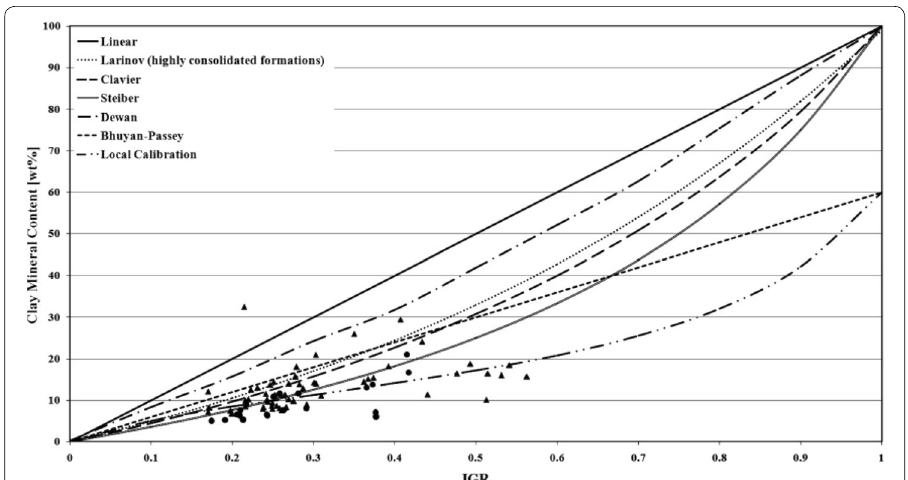
Fig. 8 The comparative look at the Shrijeh Formation weight percent clay from the core analysis and differ- ent modifications proposed by Larinov [22], Clavier [23], Steiber [24], Dewan [25], Bhuyan and Passey [10] and the empirical calibration relationship (dashed curvilinear lines). Black circle Gas producing well data points, and black up-pointing triangle the non-producing well data